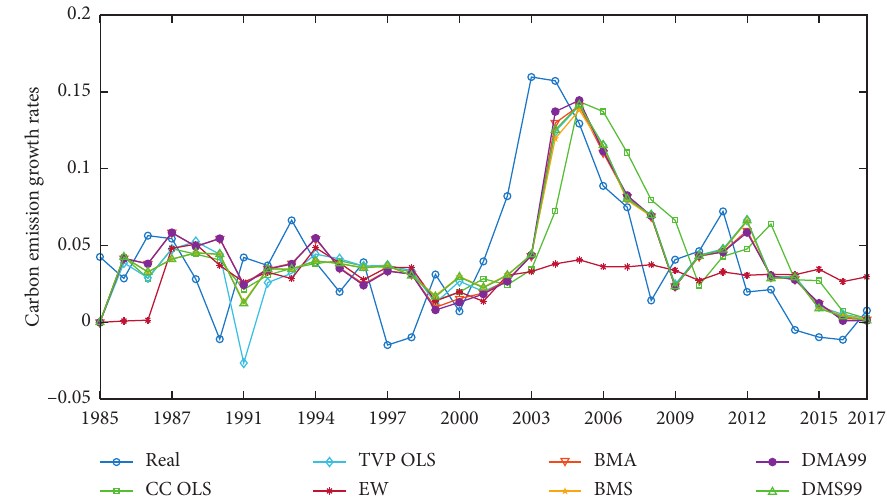
Figure 2: Carbon emission forecasting results by various models.